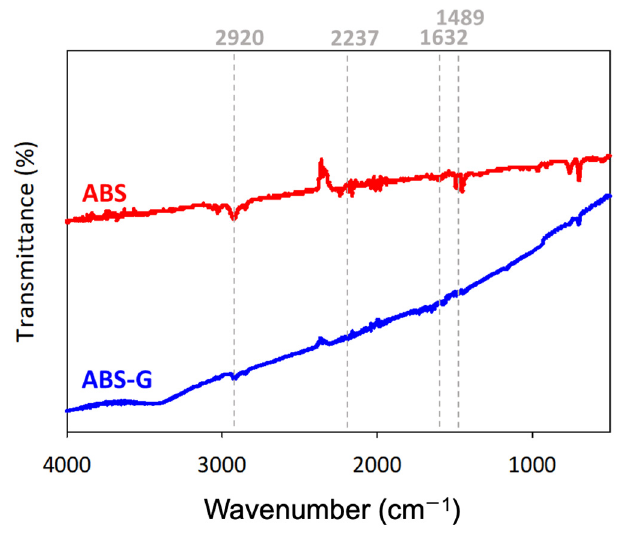
Figure 3. Fourier-transform infrared (FTIR) of 3D printed filaments.